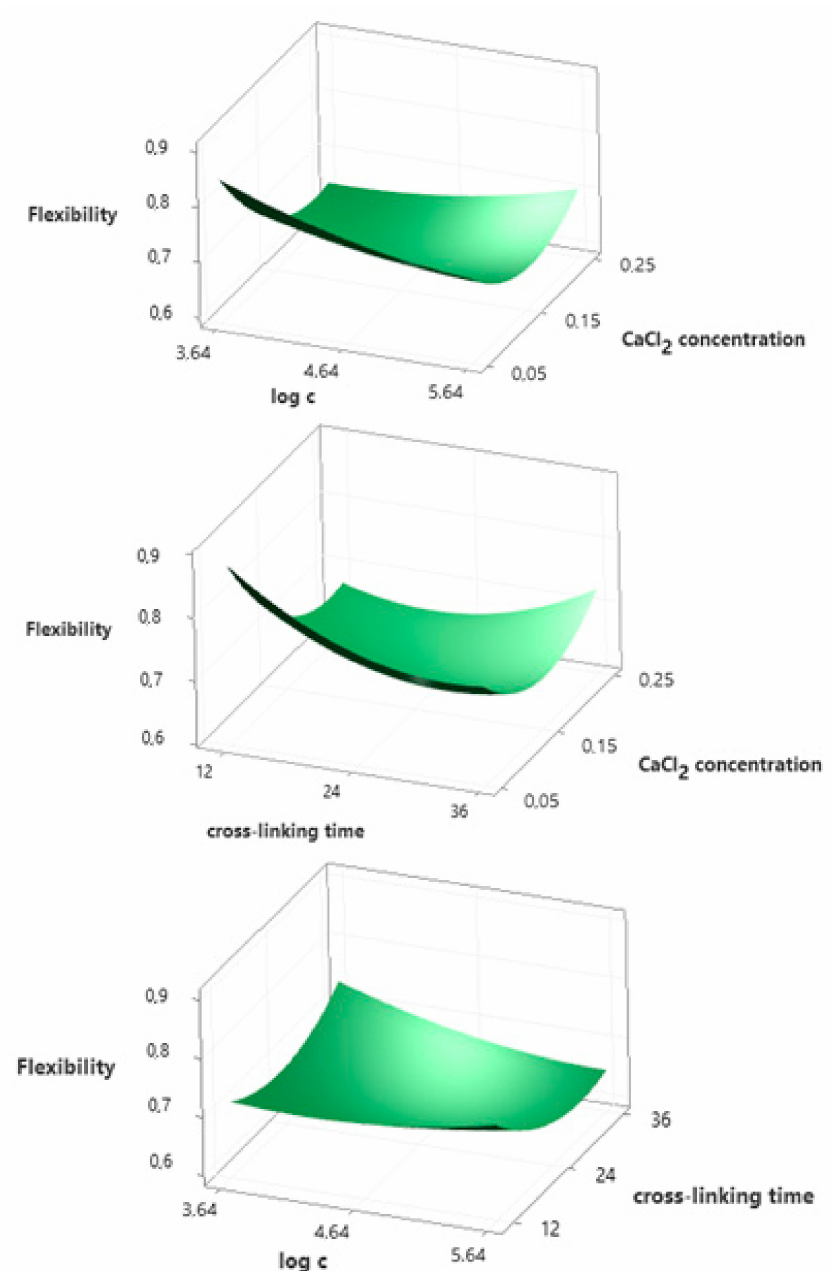
Figure 3. Surface plots presenting the effect of selected independent variables on the flexibility of